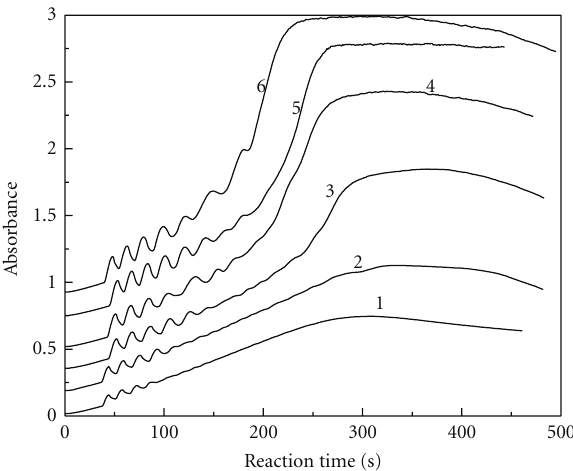
Figure 2: The absorbance versus reaction time at 289 nm for the triiodide ion. [ClO 2 ] 0 = 8 . 77 × 10 − 4 mol / L, [MAA] 0 = 6 . 29 × 10 − 3 mol / L, [H 2 SO 4 ] 0 = 3 . 50 × 10 − 3 mol / L, [KI] 0 = 2 . 72 × 10 − 3 mol / L (curve 1), 3 . 23 × 10 − 3 mol/L (curve 2), 3 . 40 × 10 − 3 mol / L (curve 3), 3 . 57 × 10 − 3 mol / L (curve 4), 3 . 74 × 10 − 3 mol/L (curve 5), 4 . 08 × 10 − 3 mol/L (curve